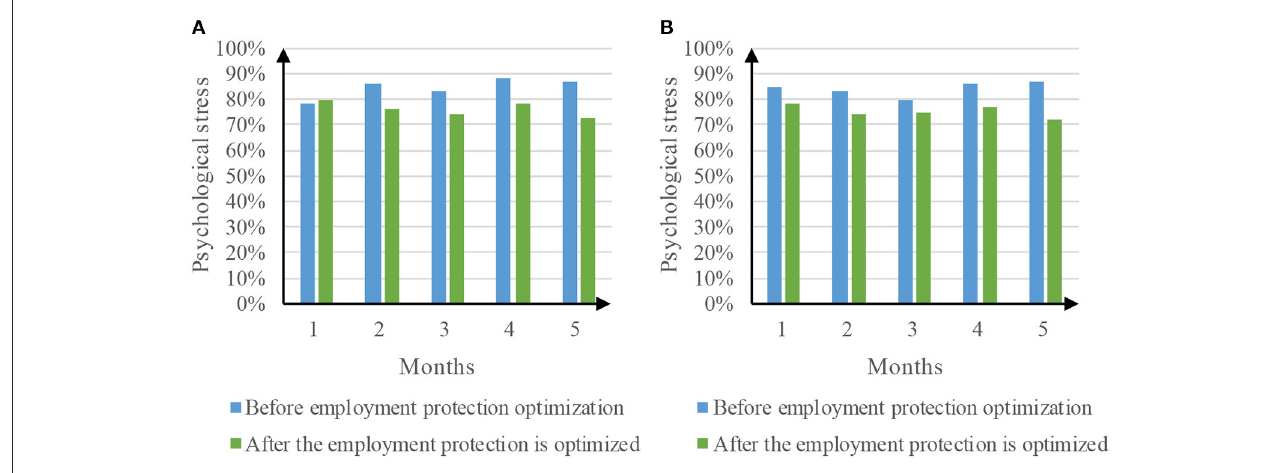
FIGURE8 Comparison results of psychological stress. (A) Psychological pressure of Meituan takeout. (B) Psychological pressure of ELEME takeout.